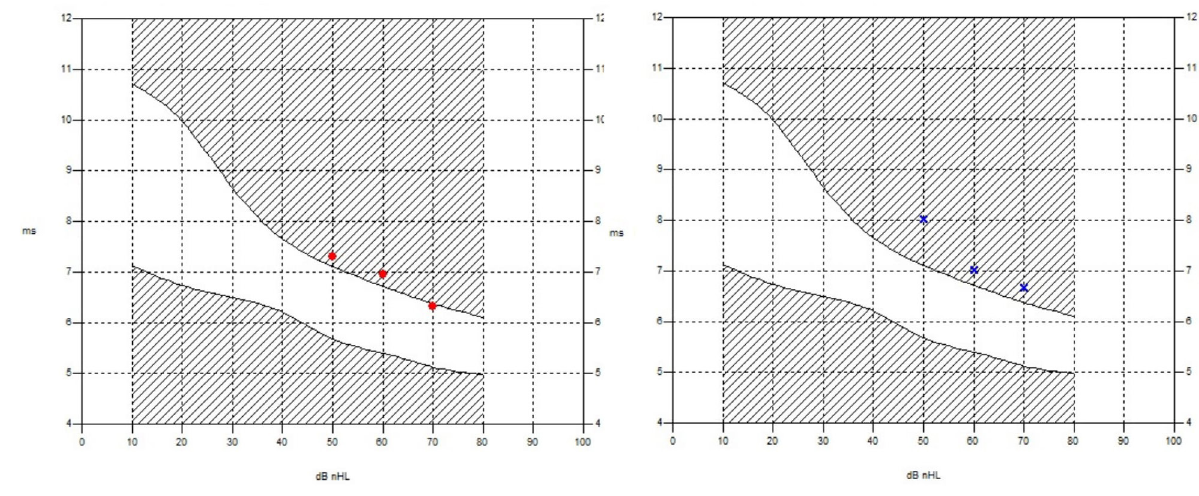
Figure 5. Wave V latency times, right and left ear.